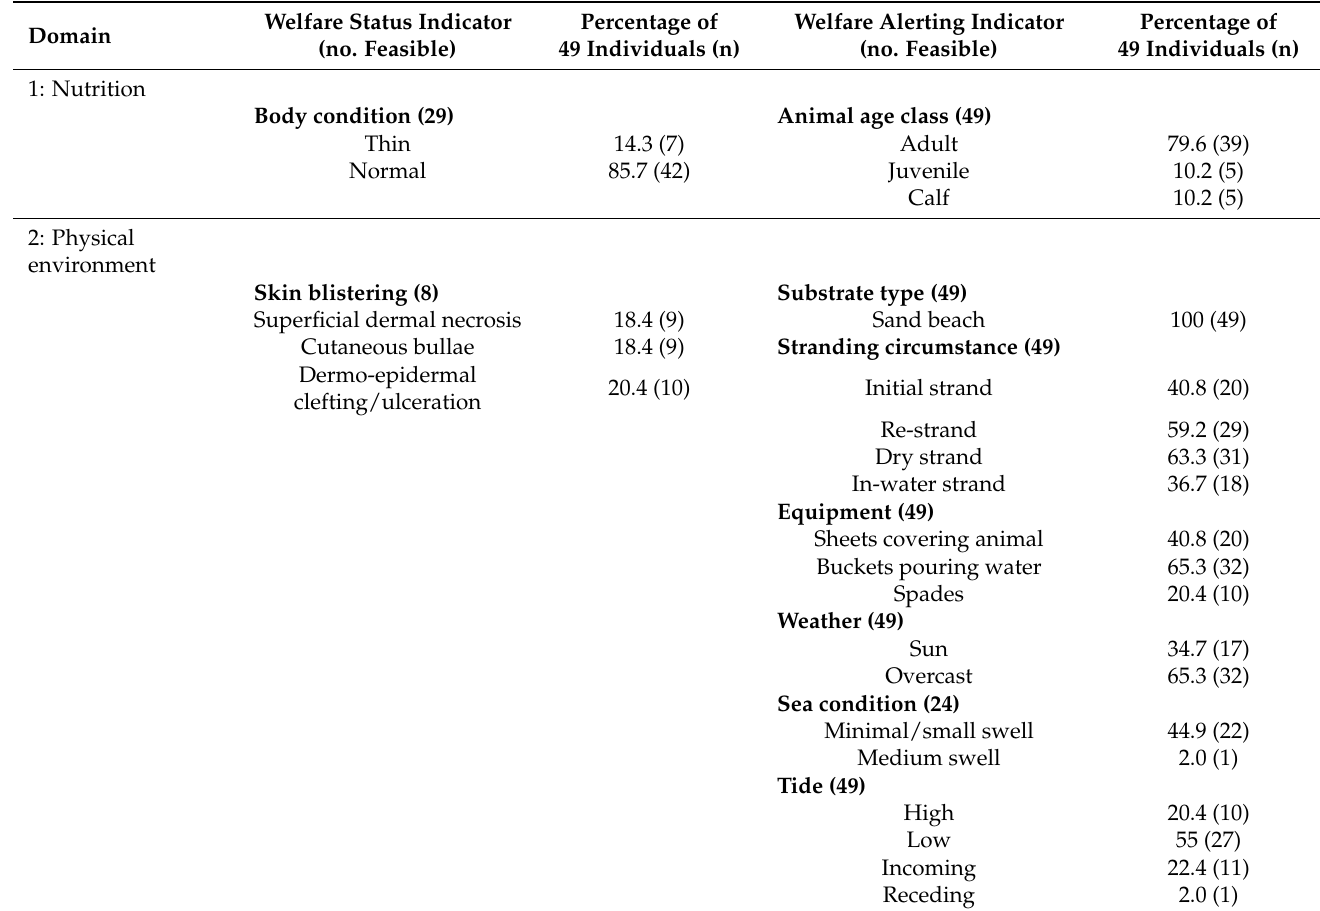
Table 2. Non-behavioural welfare indicators assessed for 49 live stranded long-finned pilot whales across 11 stranding events between August 2010 and March 2022 on the New Zealand coast. The number of animals for which the indicator was feasible to assess across the whole body and the percentage of animals for each